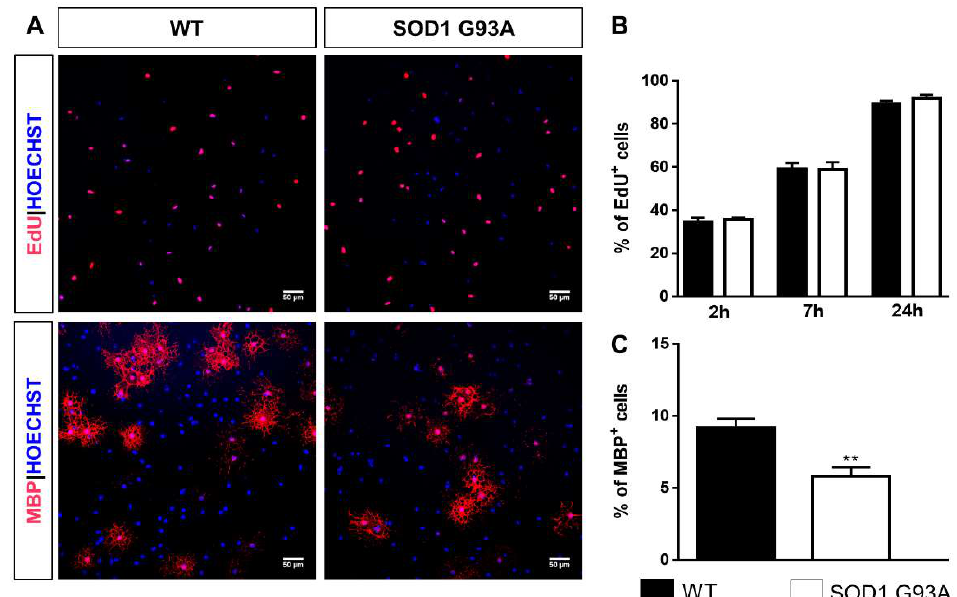
Figure 4. OPCs isolated from P7 SOD1 G93A mice exhibit alterations in di ff erentiation capabilities. ( A ) Representative images showing cells from both WT and SOD1 G93A OPC cultures that have incorporated EdU in their nuclei or have acquired a mature phenotype (MBP + cells). Hoechst33258 was used to label cell nuclei. Scale bar: 50 µ m. ( B ) Histograms showing the quantification of the percentage of proliferating cells after 2, 7, or 24 h treatment with EdU. Data are the mean ± SE of cell counts from at least three coverslips / conditions from three independent experiments. ( C ) Histograms showing the quantification of the percentage of MBP + cells in OPC cultures from WT and SOD1 G93A mice. Data are the mean ± SE of cell counts from at least three coverslips / condition from four independent experiments. ** p < 0.01 SOD1 G93A vs WT; Student’s t -test. Of note, at this time points, 74.16 ± 3.74% of GPR17 + cells of WT cultures exhibited a highly